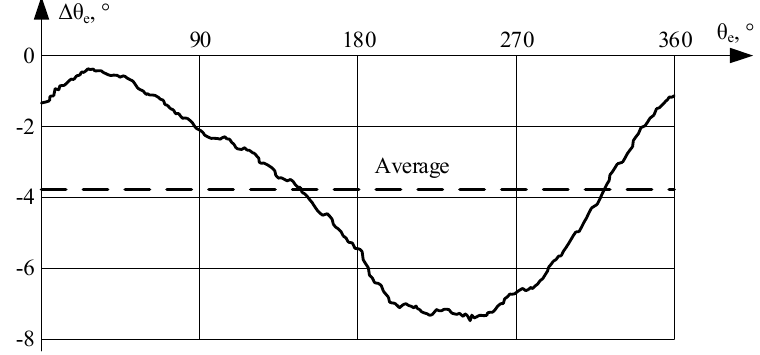
Figure 3. Rotor position estimation error.